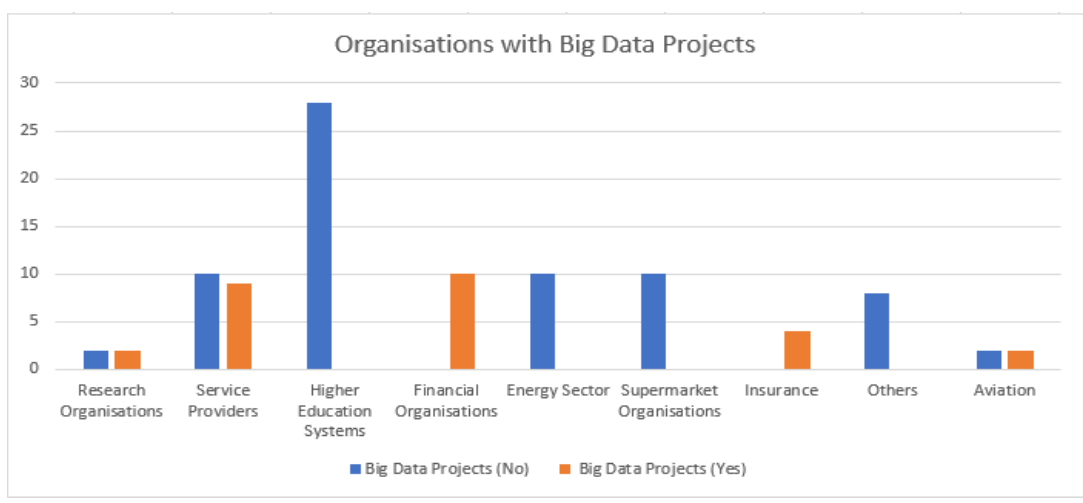
Figure 2. Organisations with Big Data projects.